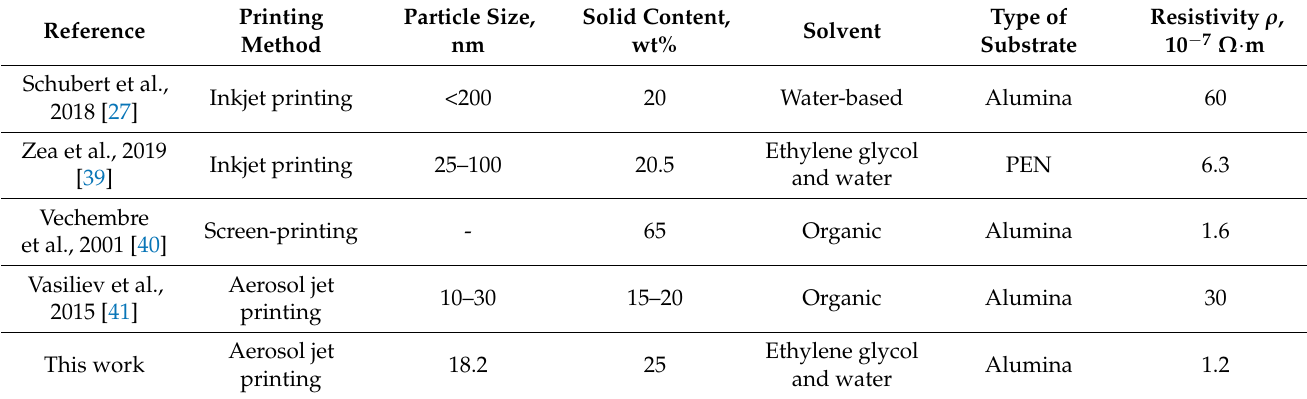
Figure 6. ( a ) Dependence of the resistivity of platinum lines on the values of FR , N p , and T sint and ( b ) typical SEM images of the surface of the sintered line, printed with optimized parameters. Table 3. Comparison of the resistivity of platinum structures and parameters of Pt